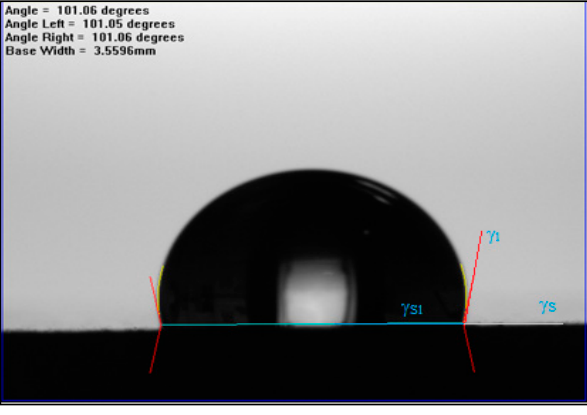
Figure 1. Contact angle between liquid and solid surfaces.